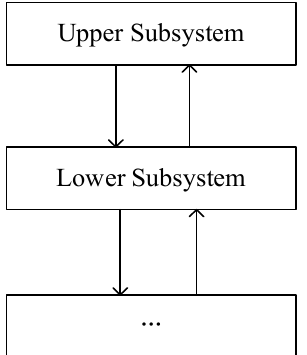
Figure 2. Hierarchical safety control structures.